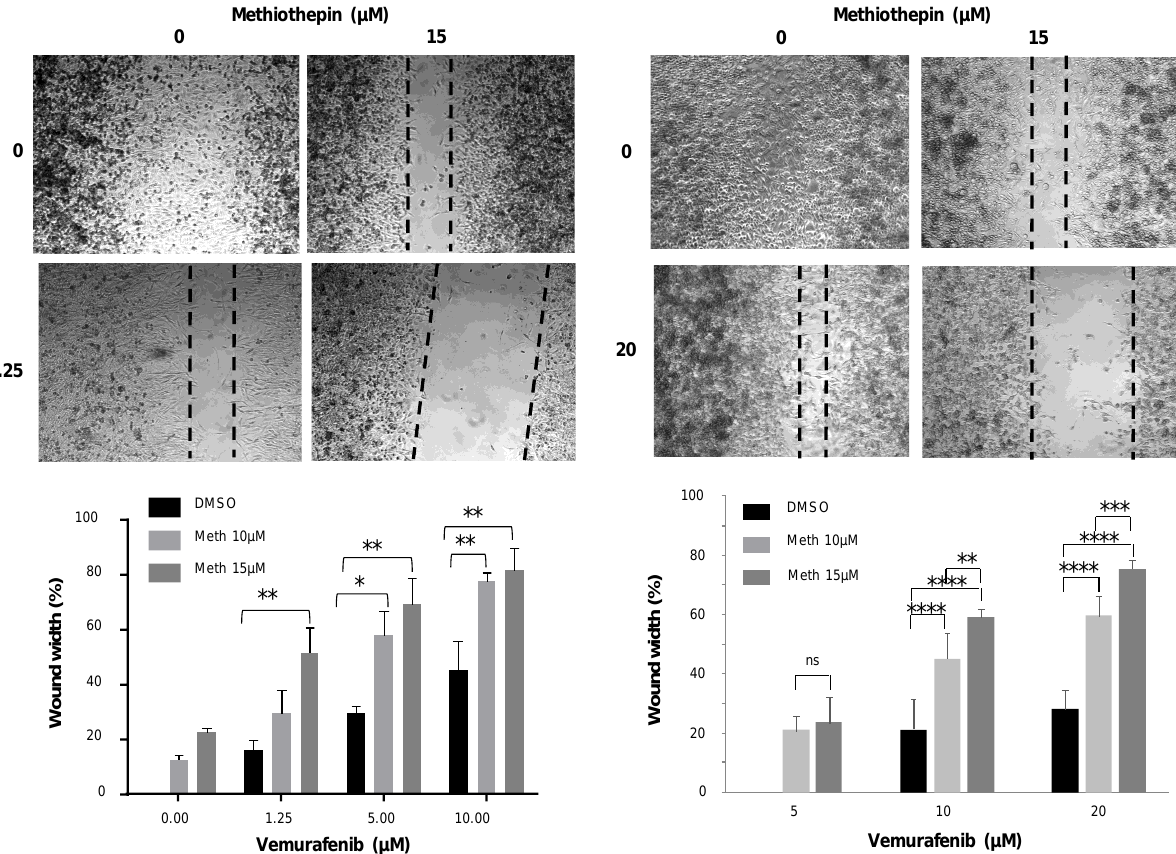
Figure 8. Methiothepin increases vemurafenib effect on cell migration. Migration was measured using a wound-healing assay. A wound was performed on A375 and WM9R confluent cells seeded in 24 well plates. The medium was replaced by fresh medium containing increasing concentrations of vemurafenib in the absence of methiothepin (meth), or in the presence of 10 or 15 µM of methiothepin. Two pictures were taken at two different points of each well immediately after wound, and 48 h after wound with a 5× objective. The width of the wound was measured using ImageJ software and reported as final wound width/initial wound width in percentage. Data presented are the mean ± SEM of three independent experiments. Significance was attained at p < 0.05 (*) (**: p < 0.005, ***: p < 0.0005, ****: p < 0.00005).